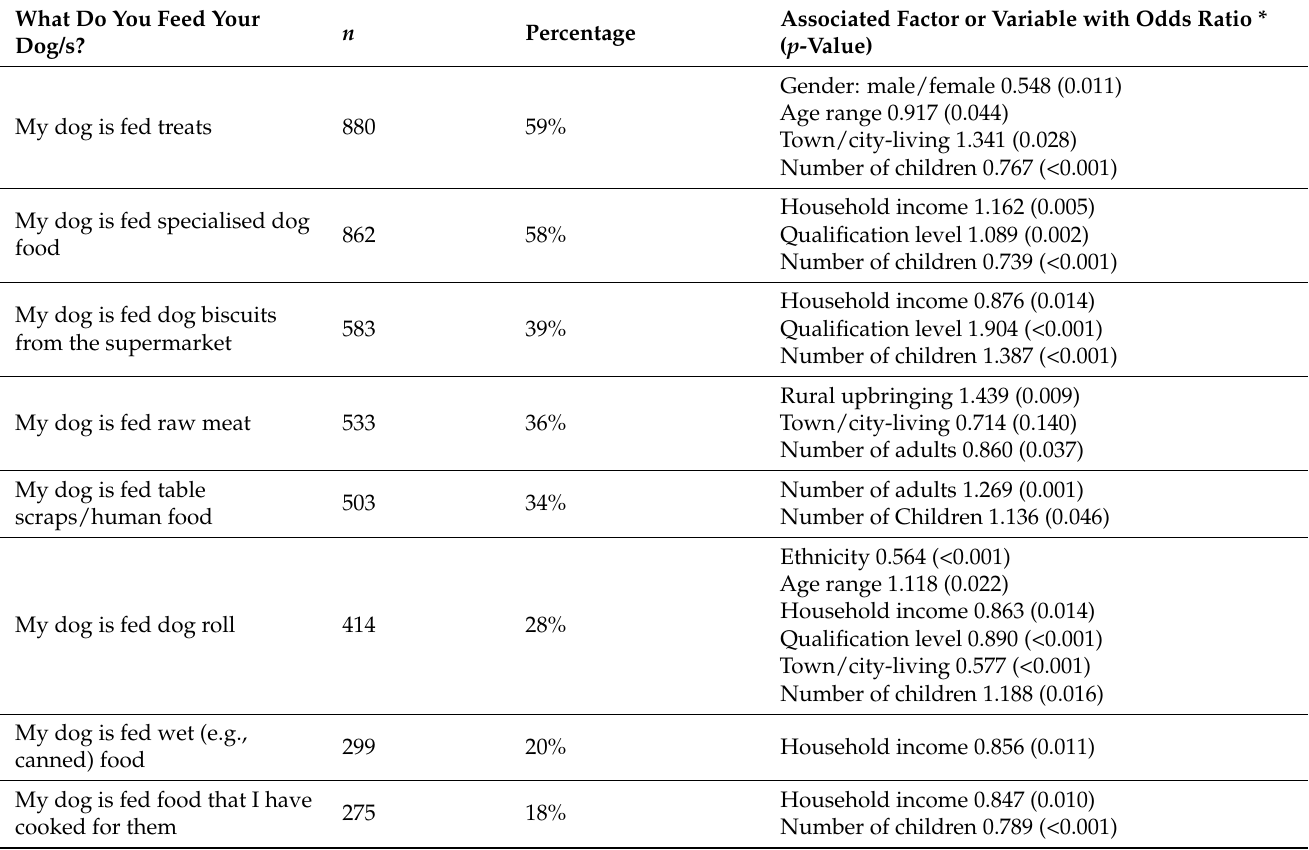
Table 1. Positive responses to the question “Which of these apply to your dog/s?” along with factors and variables that impact the likelihood * of a positive response in the EIT Pet Survey